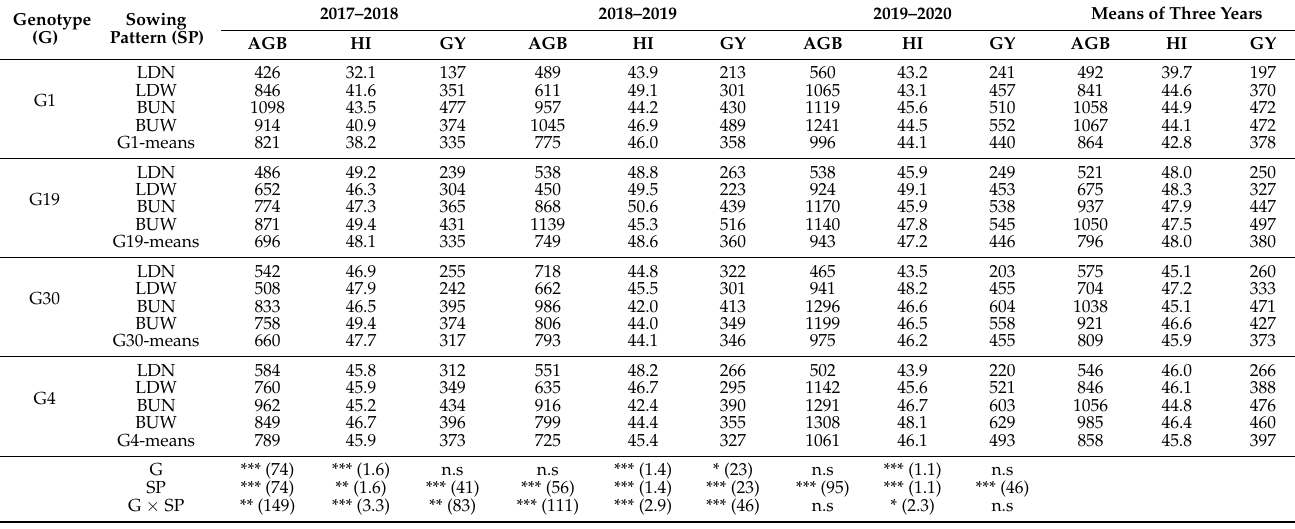
Table 1. The above-ground biomass (AGB, g m − 2 ), harvest index (HI, %) and grain yield (GY, g m − 2 ) and their means of four wheat genotypes under four different sowing patterns during three consecutive growing seasons. LSD values at p = 0.05 are in parenthesis. n.s not significant, * p < 0.05, ** p < 0.01, *** p < 0.001. Genotype Sowing (G) Pattern